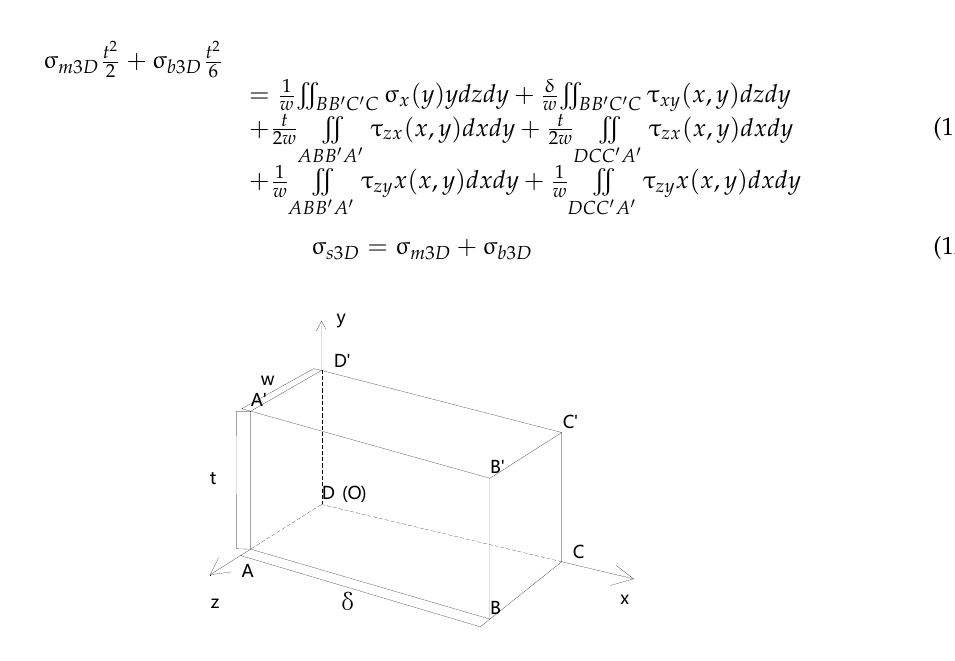
Figure 7. 3D isolation body.